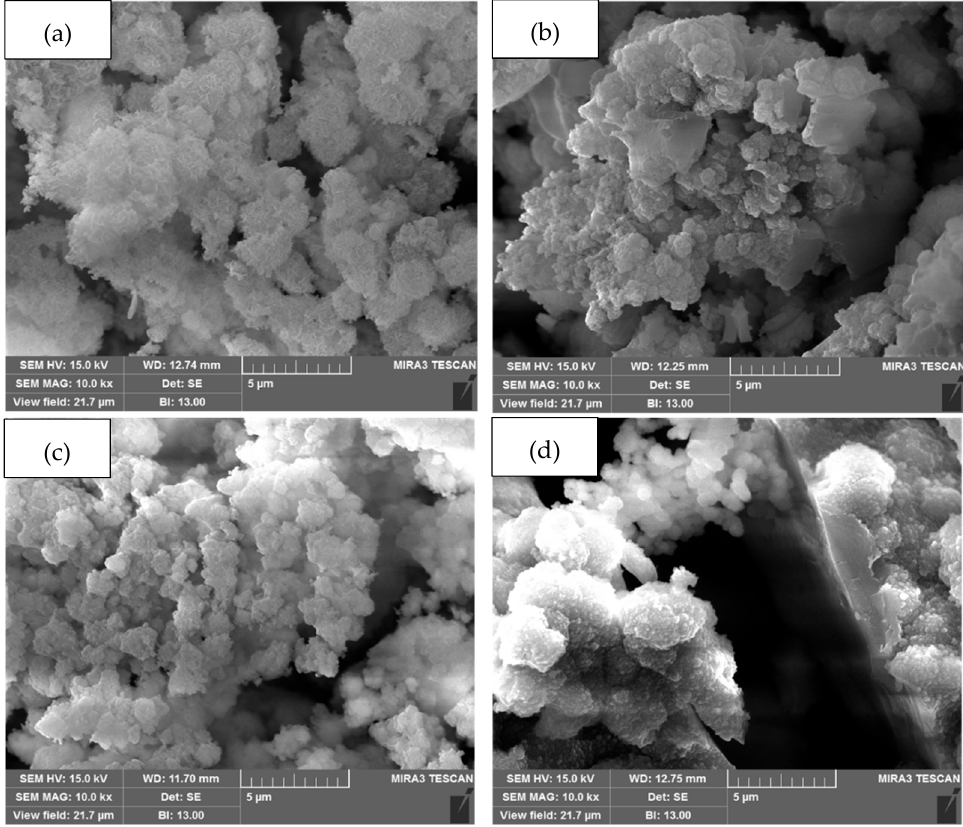
Figure 10. SEM of corrosion products formed onto ( a ) AC, ( b ) SPCN1, ( c ) SPCN2, and ( d ) SPCN3 surface after 89 days of exposure in 3.5 wt.% NaCl solution.